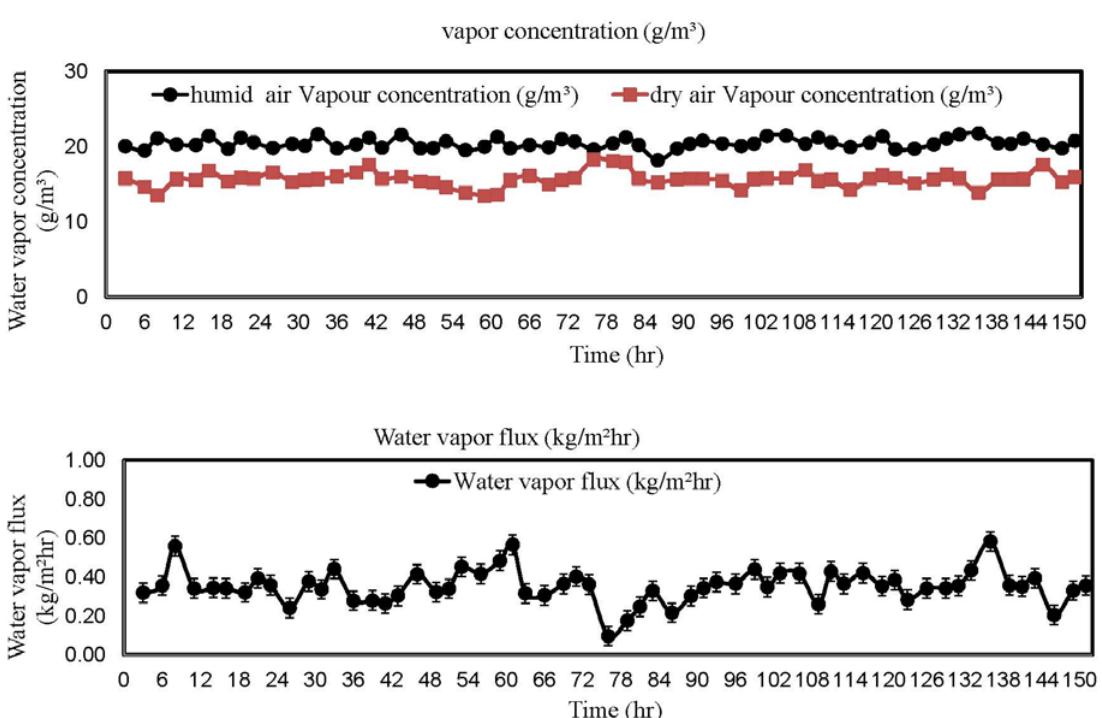
Figure 8. Water vapor concentration and flux vs .